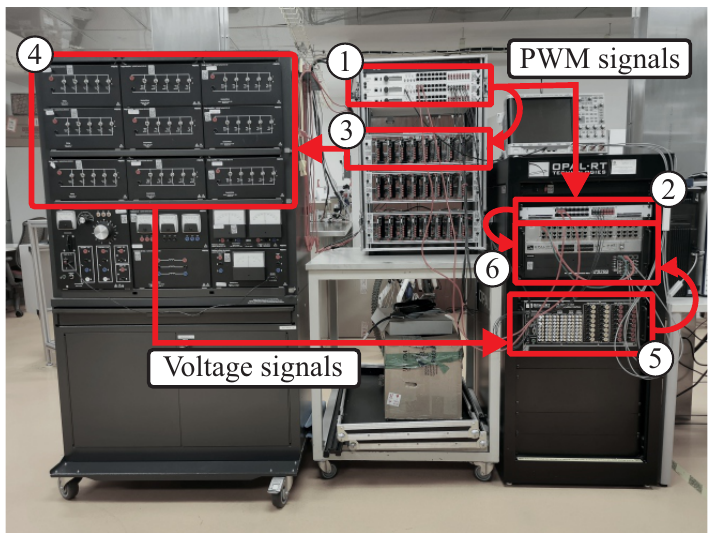
Figure 13. Hardware setup: 1. Imperix Boombox; 2. Imperix/OPAL simulation interface; 3. Imperix IGBT-based power module; 4. LabVolt by Festo; 5. OPAL HIL Controller; 6. OPAL